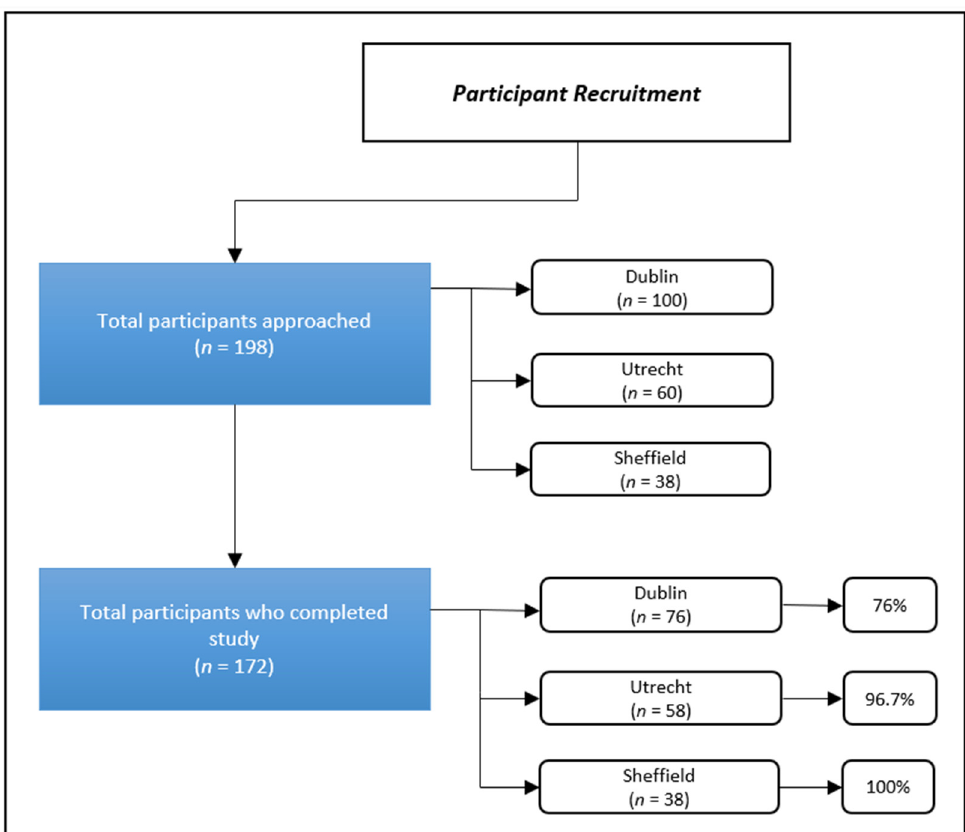
Figure 1. Participant recruitment. Participants were included in this analysis if they completed demographic data, at least one measure, and the open-ended question.